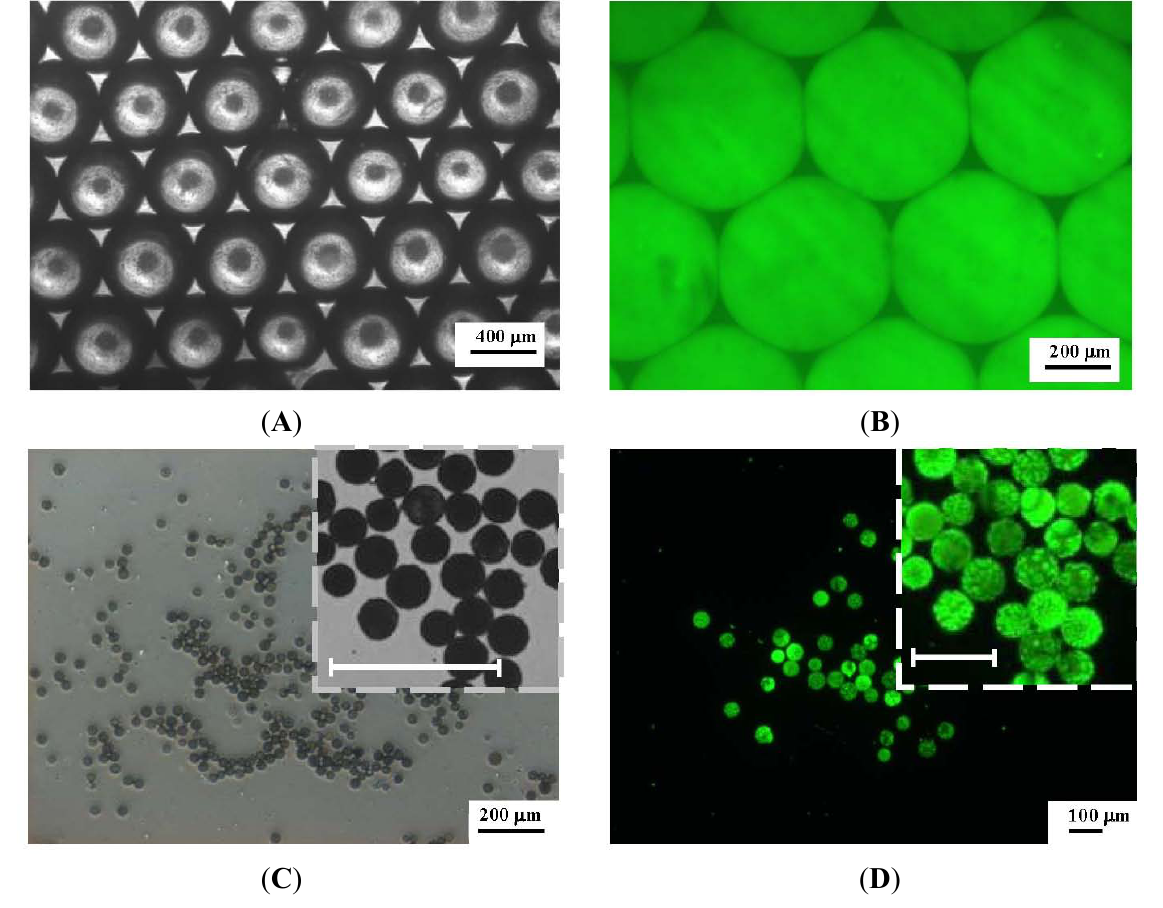
Figure 5. Micrographs of monodispersed PLGA droplets ( A ) bright-field (Scale bar = 200 μ m) ( B ) fluorescent images (Scale bar = 200 μ m), and microparticles ( C ) bright-field (Scale bar = 200 μ m) and ( D ) fluorescent images (Scale bar = 100 μ